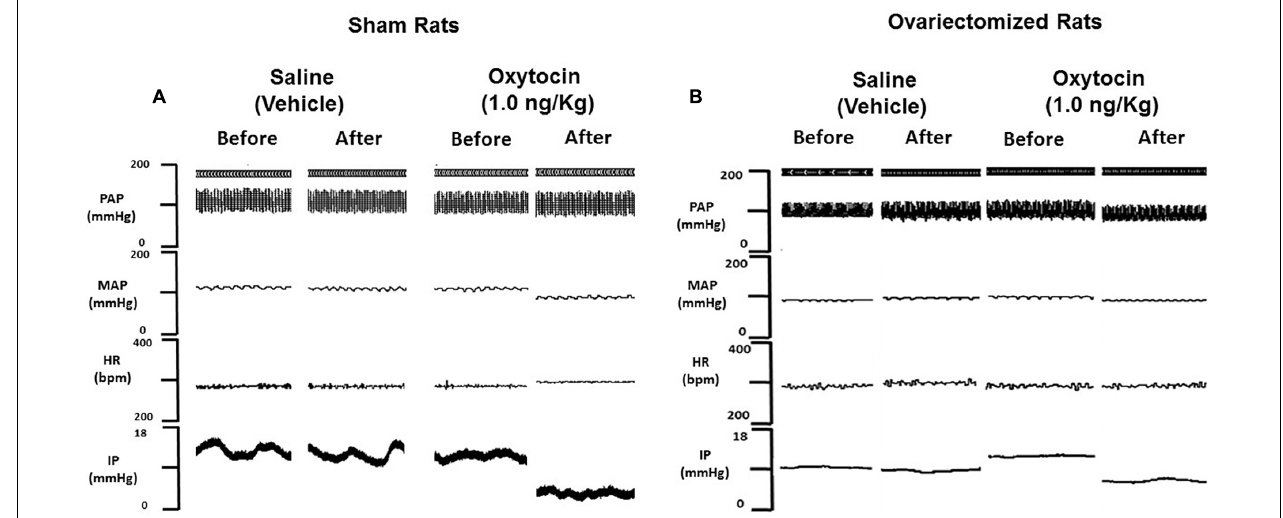
FIGURE 3 | Tracings showing pulsatile arterial pressure (PAP, mmHg), mean arterial pressure (MAP, mmHg), heart rate (HR, bpm) and intravesical pressure (IP, mmHg) before and after intravenous infusion of saline (vehicle) or oxytocin 10 ng/kg in sham (A) and ovariectomized (B) rats.